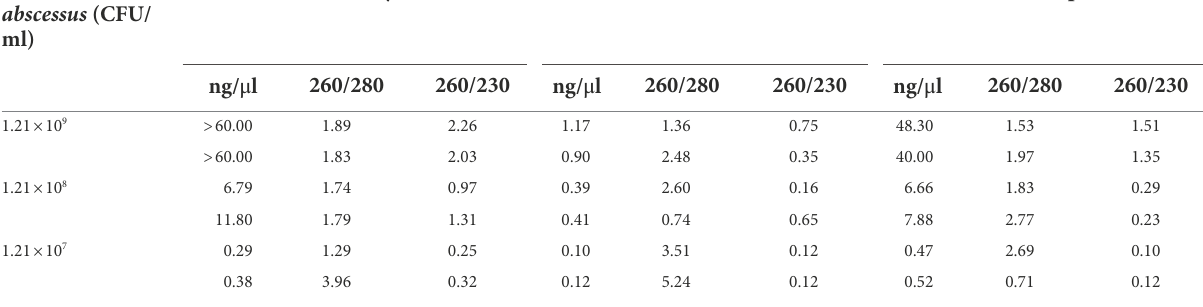
Rows per concentration represent replicates.